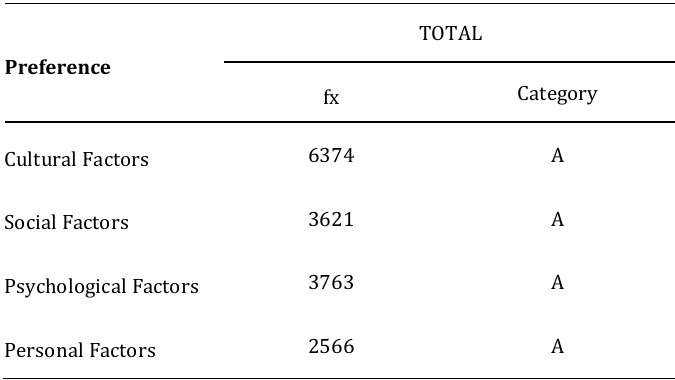
Table 5 Overall Analysis of Tourist Preference